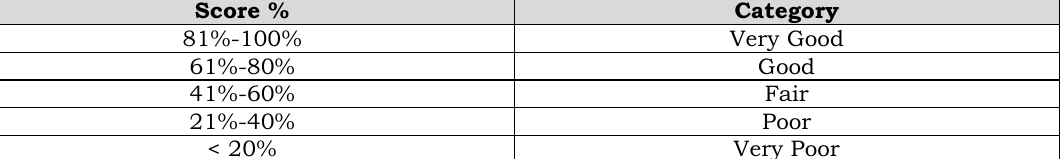
Table 3. Percentage of Validity Criteria